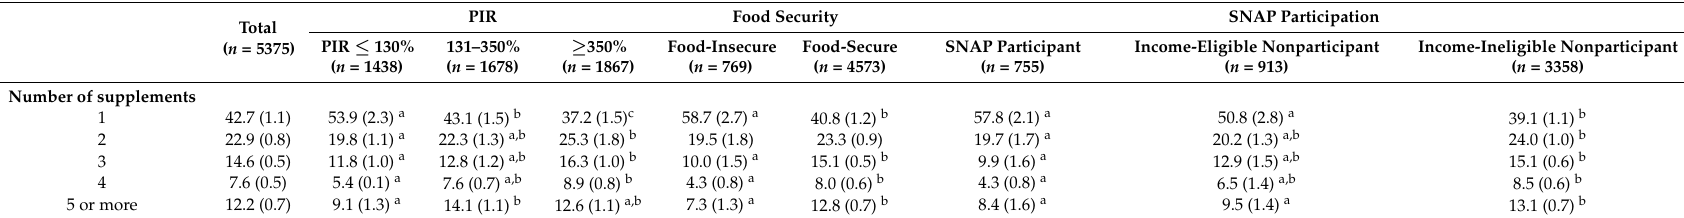
Table 4. Estimated prevalence (%) of dietary supplement use by number of dietary supplements taken and selected poverty indicators among U.S. adult supplement users, 2011–2014 1,2